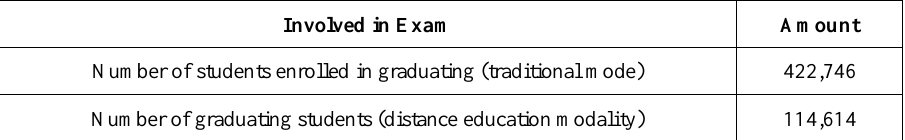
Table 3. Number of students involved and. Type of education [47].